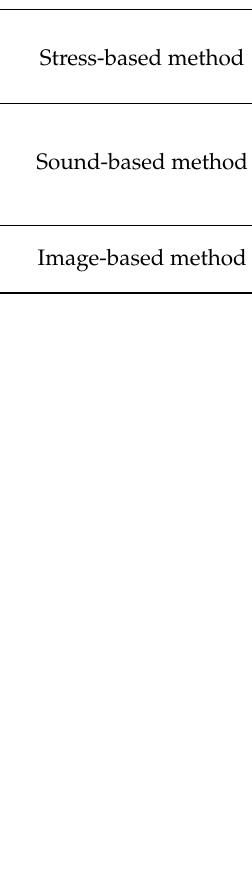
Table 1. Advantages and disadvantages of stress-based, sound-based, and image-based techniques.